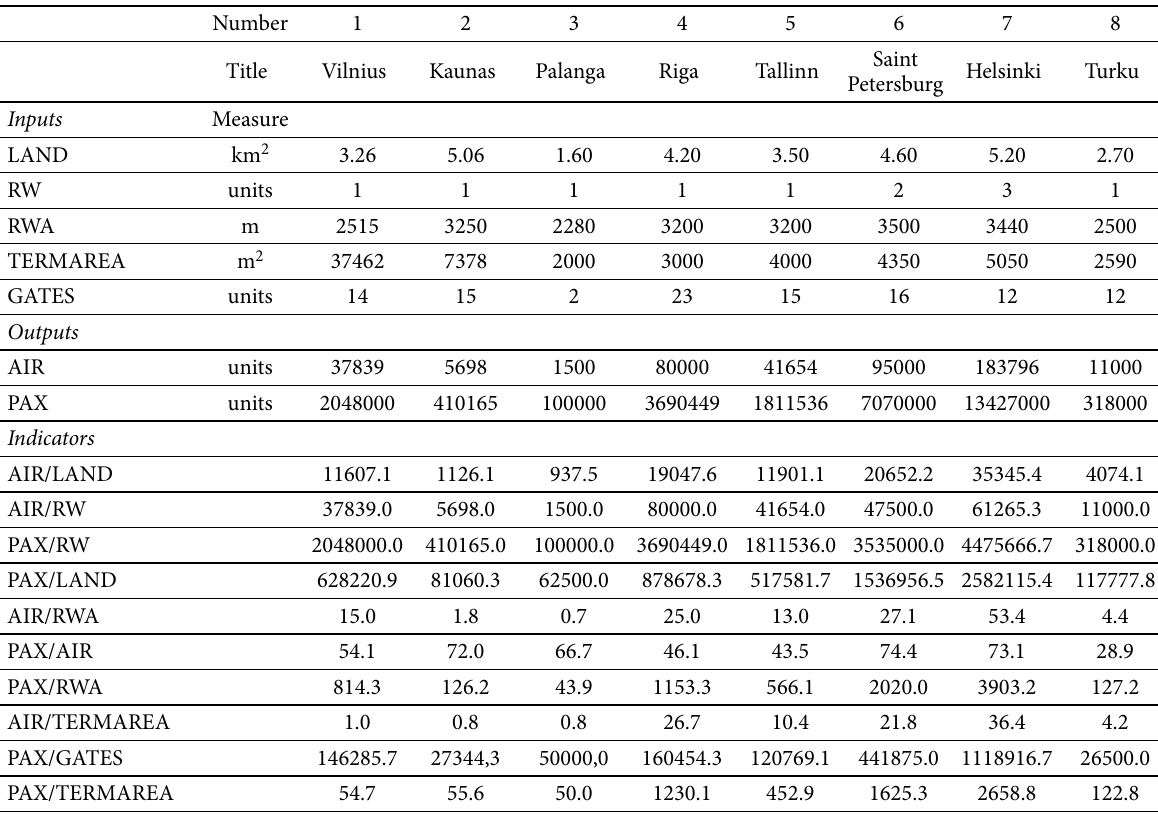
Table 1. The parameters of the airports selected for study (1)